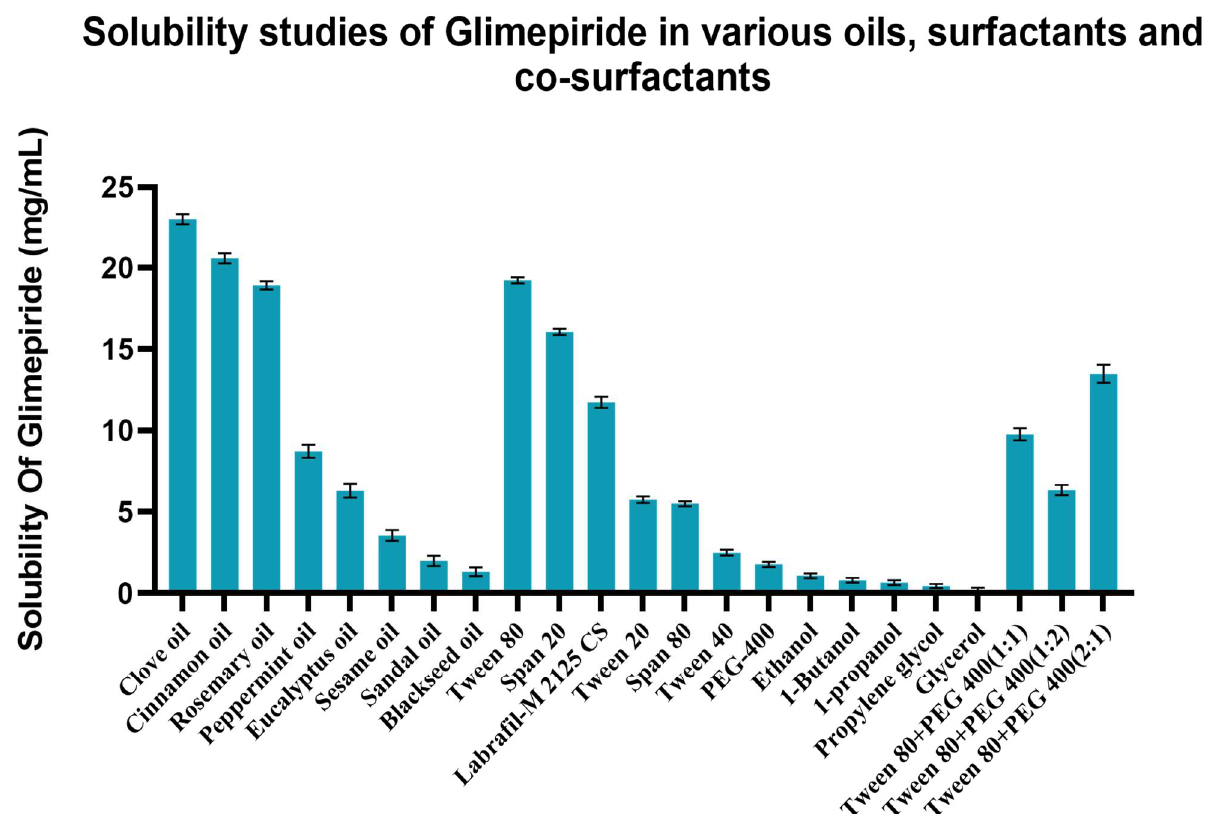
Figure 1. Solubility studies of glimepiride in various oils, surfactants, and co-surfactants ( n =